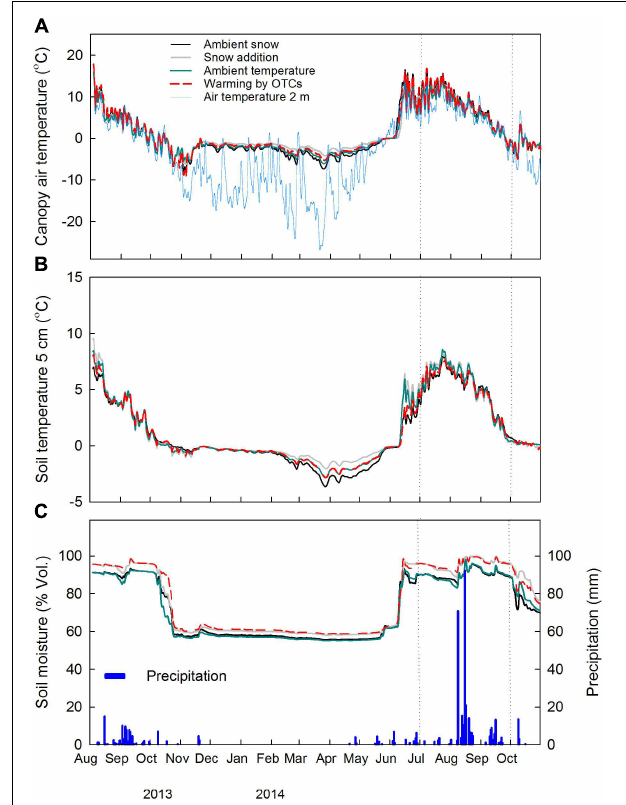
FIGURE 1 | Continuous measurements of (A) air temperature within the canopy (2 cm above soil surface) and air temperature at 2 m height, (B) soil temperature and (C) soil moisture and precipitation at the site in 2013–2014 ( n = 3). Daily averages of the main factors ± snow accumulation and ± warming with OTCs are shown. Dotted vertical lines indicate the study period. A common legend to all three graphs is reported in (A) .